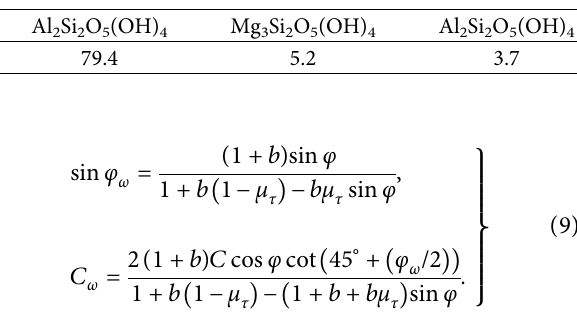
Table 1: The mineral ingredient of the inclined